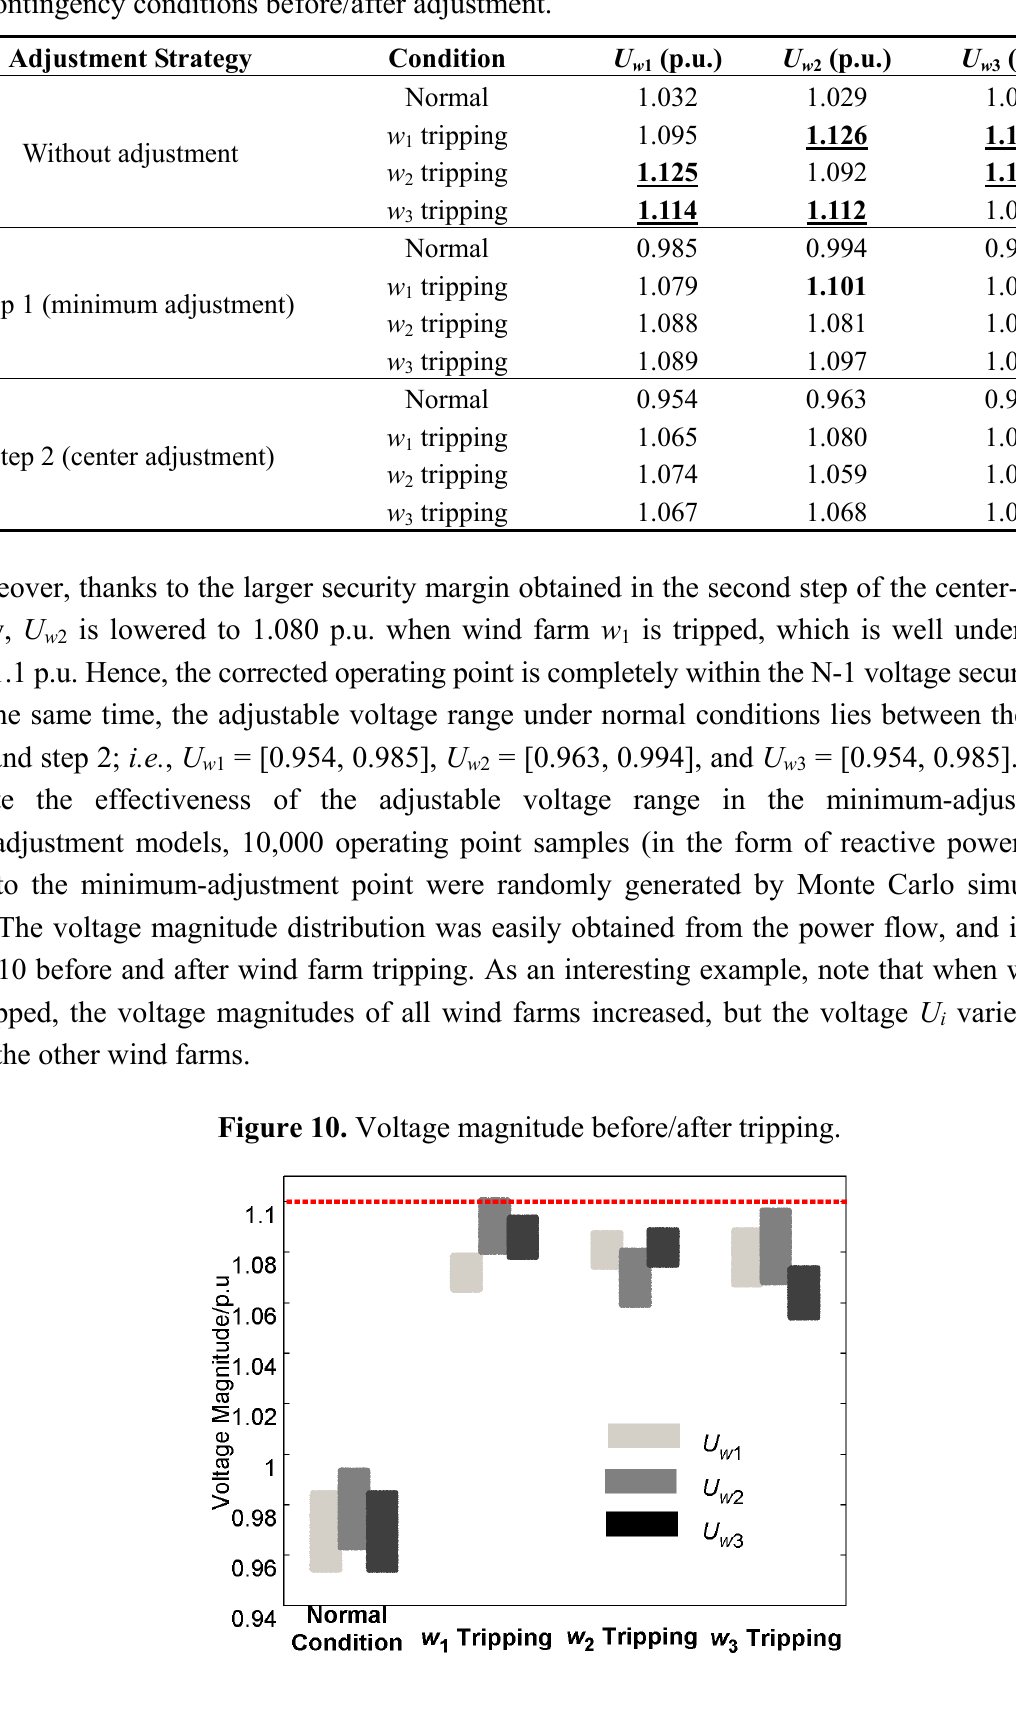
Table 5. Comparison of the voltage magnitudes at the wind farms under normal and N-1 contingency conditions before/after adjustment.